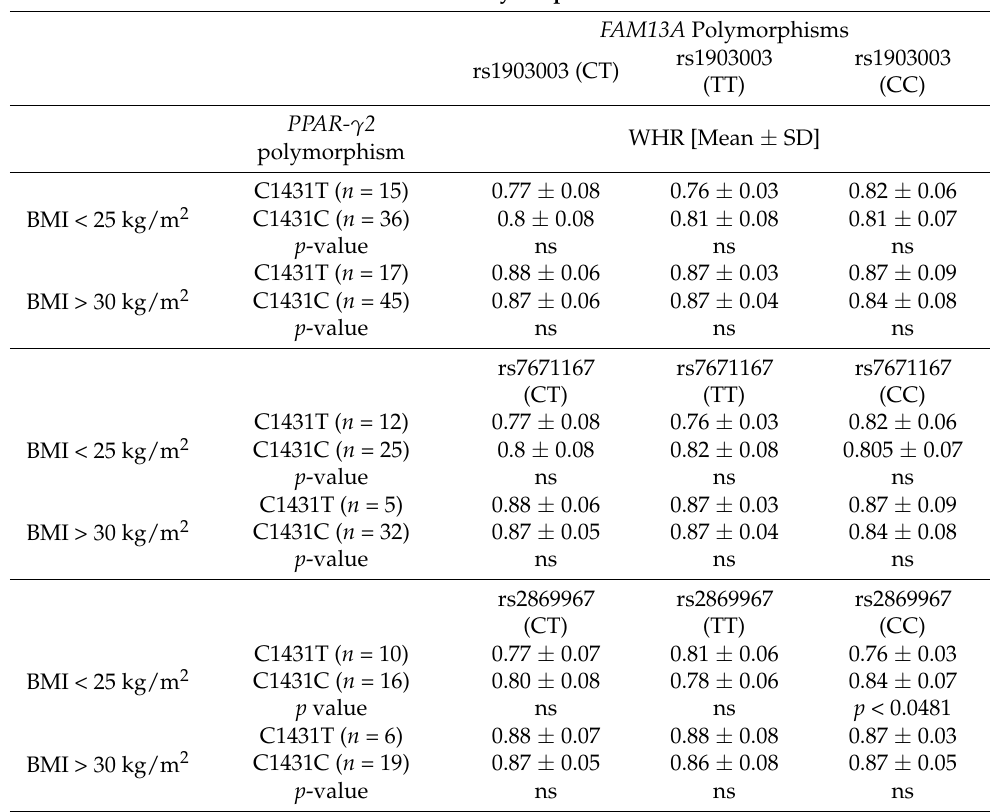
Table 4. Characteristics of fat distribution (WHR) in lean and obese women. Analysis of Fat Distribution (WHR) According to BMI [kg/m 2 ] Value in the Co-Existence